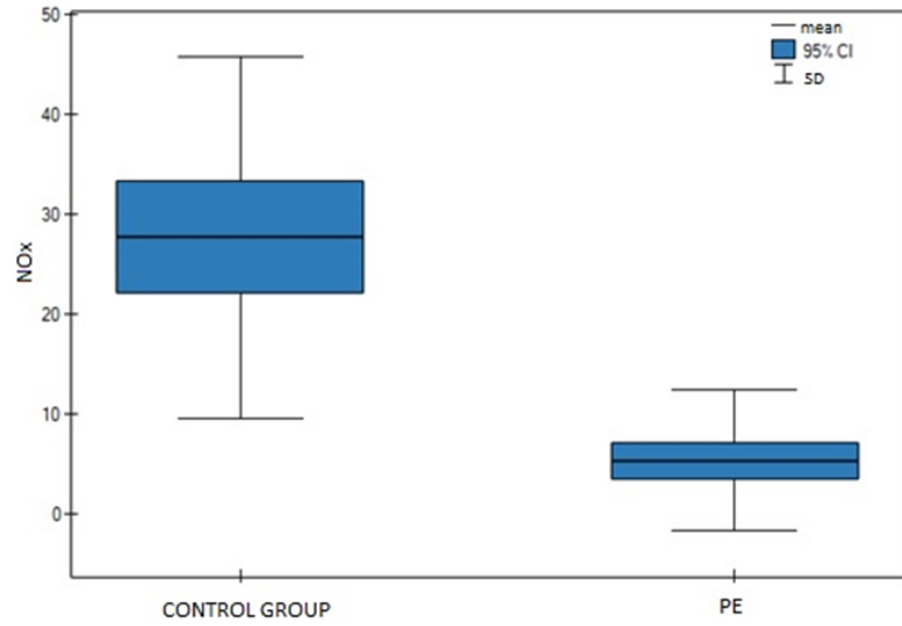
Figure 1. Mean NOx concentrations. Table 2. NOx concentrations .